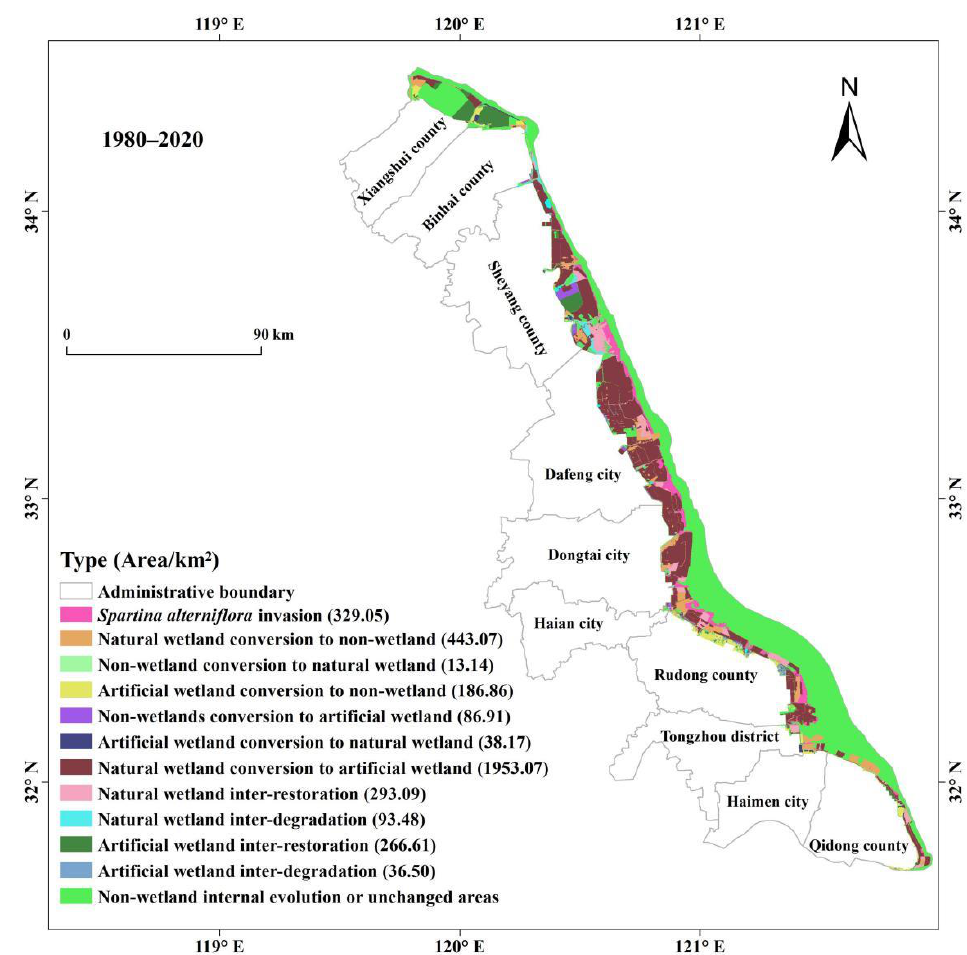
Figure 7. The spatial distribution pattern and types of wetland landscape evolution in the past 40 years.